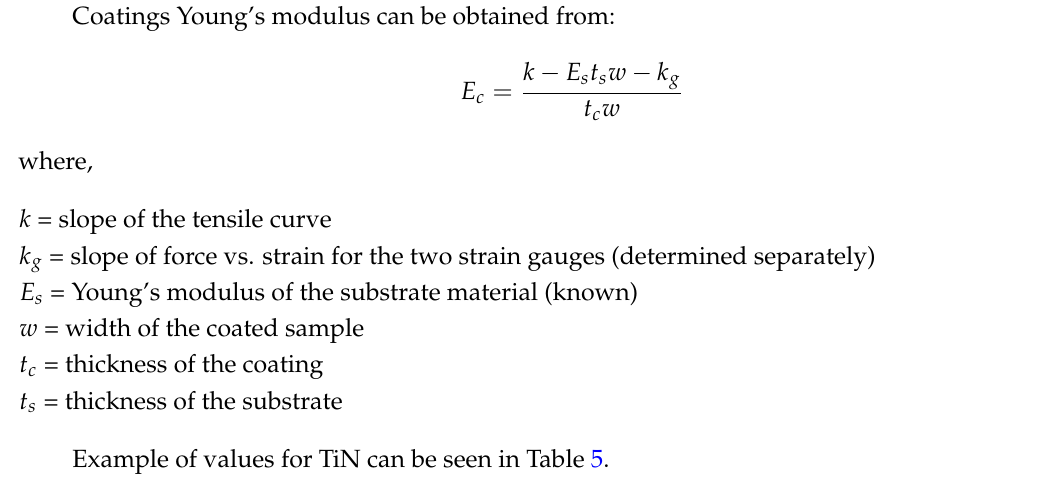
Table 5. Example of Young’s modulus data for TiN